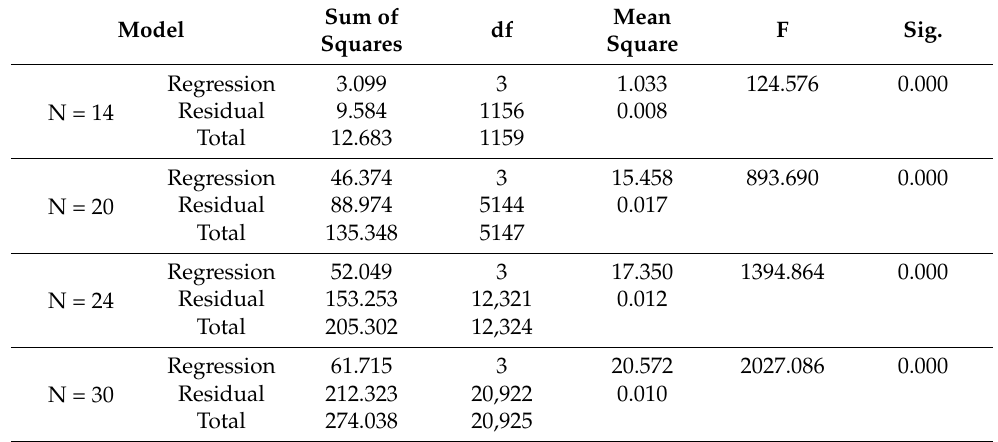
Table 3. ANOVA results for the multiple regression models for deceleration.